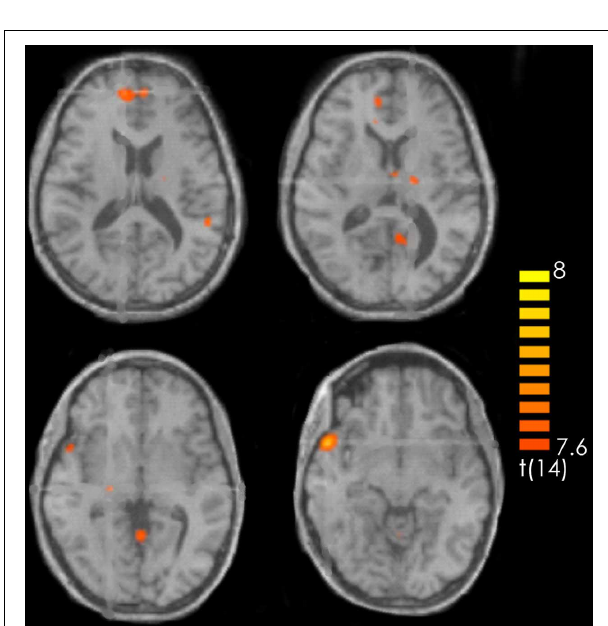
FIGURE 3 | Contrast of recognized positive > recognized less positive target pieces over all participants. The red-colored regions represent activation for the recognized positive target pieces. p < 0 . 001 (not